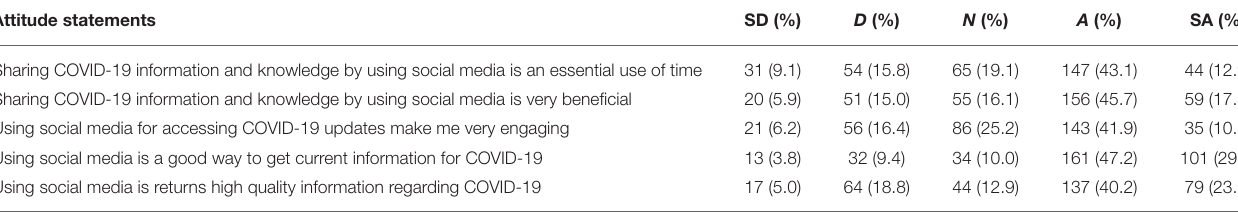
TABLE 3 | Health professionals’ attitude toward the use of social media for COVID-19-related information ( n = 341). Attitude